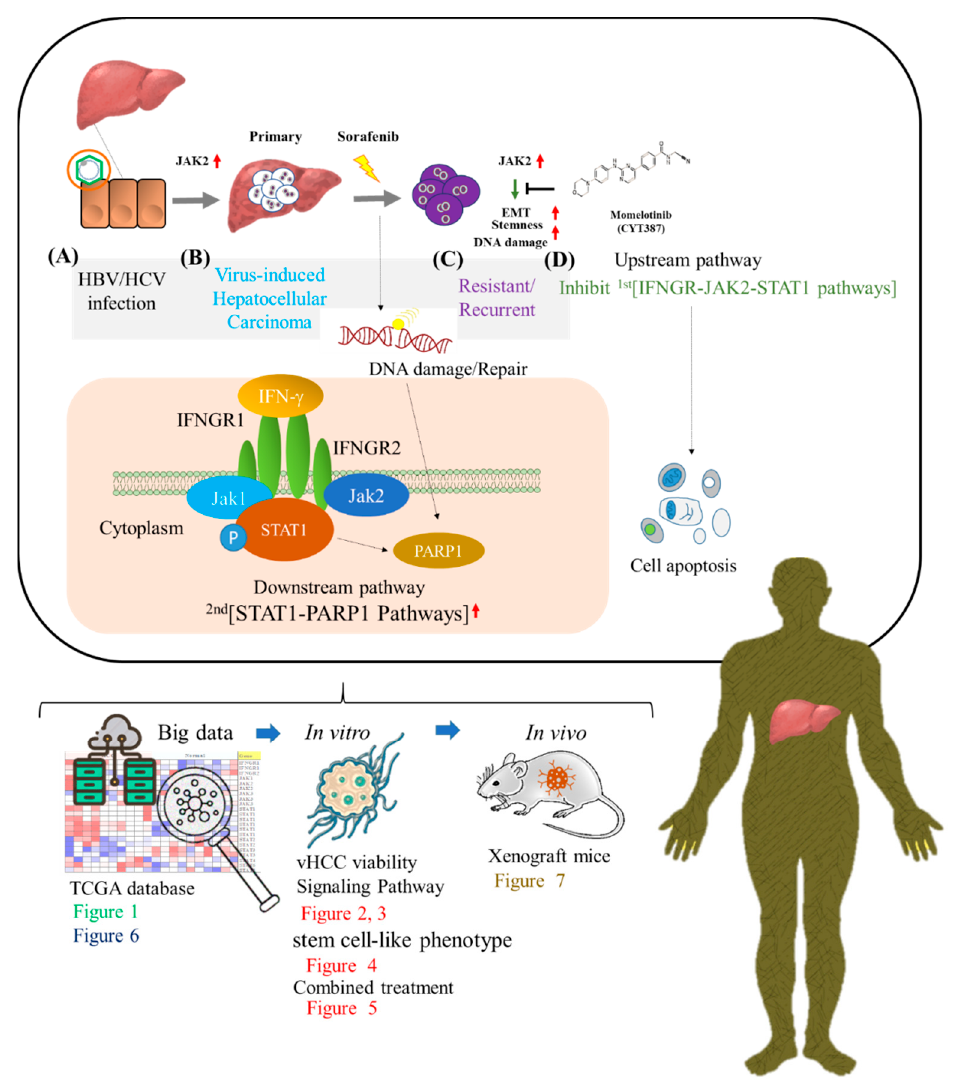
Figure 8. Schematic diagram and experimental designs. Jak2 overexpression afforded drug resistance to cancer cells, specifically in HBV/HCV-infected HCC, and the inhibition of Jak2 by momelotinib (JAK2 inhibitor) effectively suppressed HCC. This cancer development process includes four stages: ( A ) HBV/HCV infection. ( B ) Virus-induced hepatocellular carcinoma. ( C ) Sorafenib treatment causes DNA damage and initiates the STAT1-PARP1 pathway for DNA repair, which then forms resistant/recurrent cancer cells. ( D ) Momelotinib inhibits the upstream pathway of IFNGR-JAK2-STAT1, inhibits the downstream STAT1-PARP1 DNA repair pathway, and causes cancer cell apoptosis.